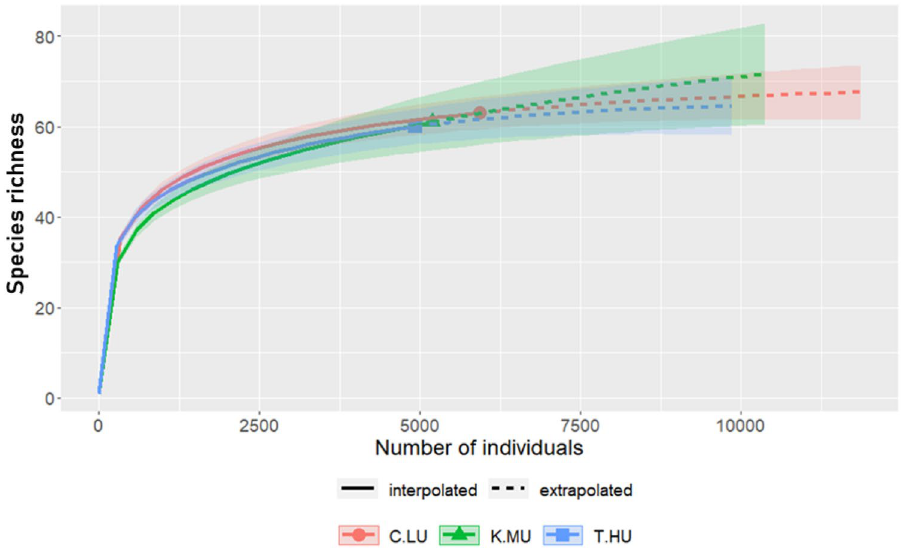
Figure 2. Individual-based rarefaction plots show the observed and rarefied species richness in three locations. C.LU = less-urbanized Kodagu; K.MU = moderately-urbanized Kasaragod; T.HU = highly-urbanized